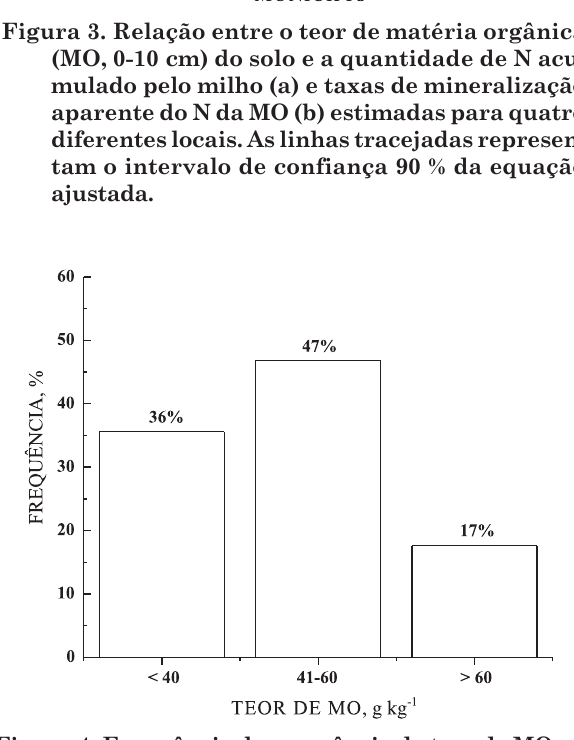
Figura 5. Efeito das plantas de cobertura de inverno na disponibilidade de N ao milho, sendo apresentada a forma pela qual foi estimada a equivalência em N mineral para os sistemas com nabo forrageiro, consórcio gramínea-leguminosa e ervilhaca isolada (a), e os valores médios de equivalência em N mineral dessas pré-culturas